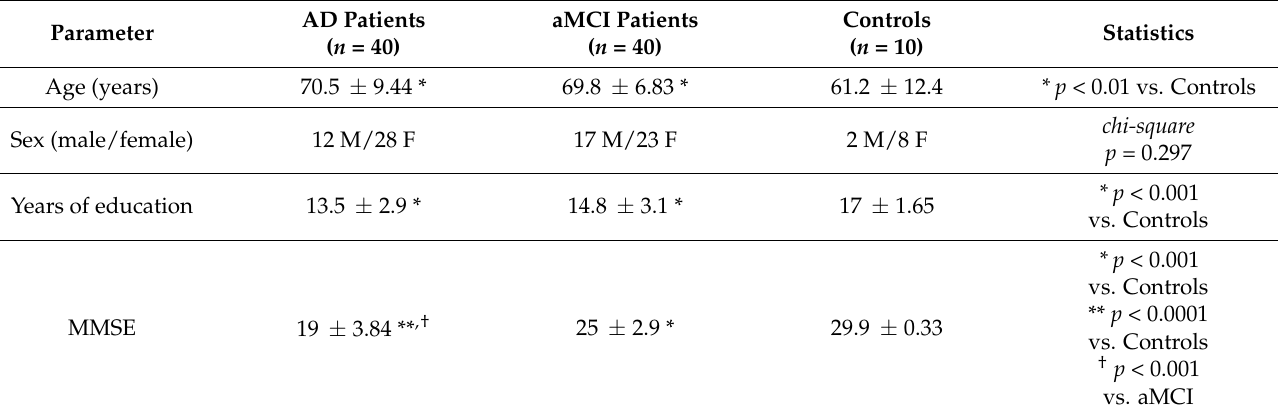
Table 1. Clinical and demographic characteristics of AD, aMCI patients, and healthy subjects.